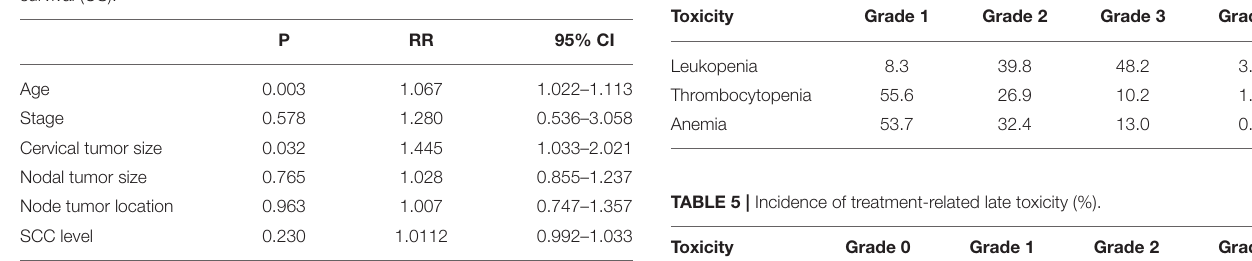
TABLE 3 | Cox proportional hazard analysis of variables predicting overall survival (OS).